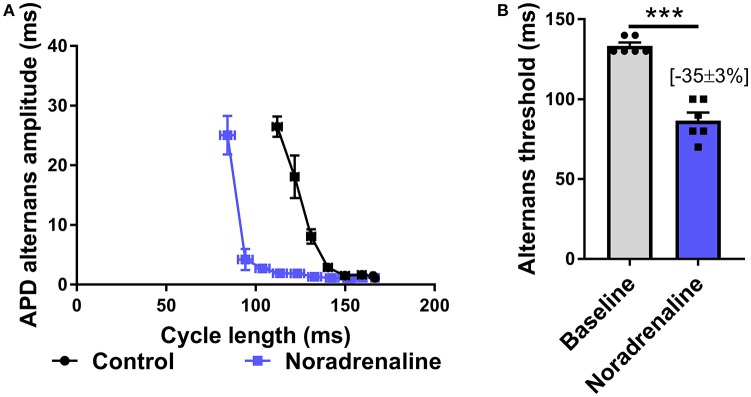
Effects of exogenous noradrenaline on action potential duration alternans. (A) Cycle length relationships of action potential duration (APD) alternans in control conditions (black) and with noradrenaline perfusion (blue). (B) Mean data of alternans threshold in both conditions. Data taken from a 3 × 3 pixel region in the basal left ventricle. Data represent mean ± SEM. Paired Student's t-test; ***p < 0.001. (n = 6 hearts).